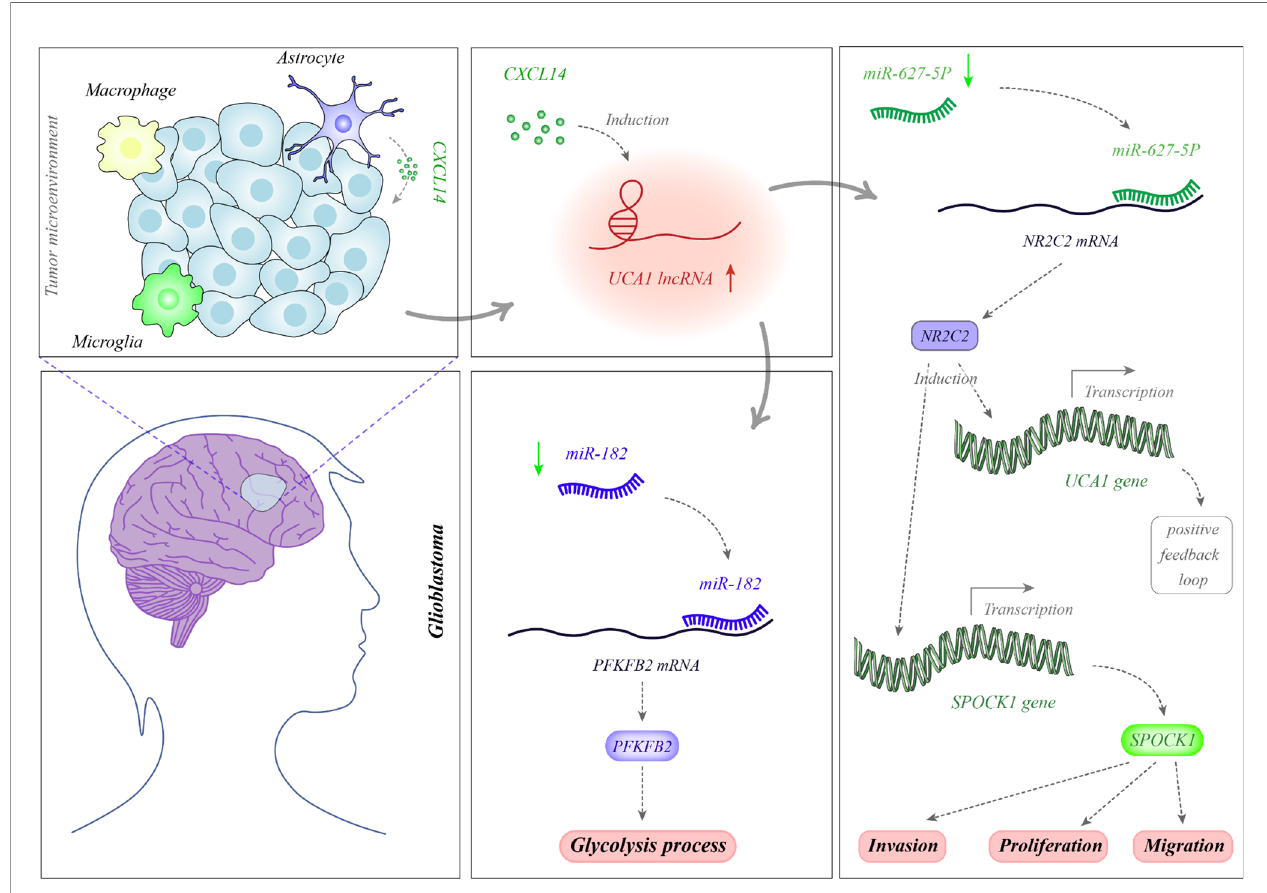
FIGURE 1 | Glioblastoma-associated stromal cells (GASCs) are special cells in the tumor microenvironment which are phenotypically and functionally similar to the cancer-associated fi broblasts. These cells produce CXCL14 which functions as a paracrine factor to enhance expression of UCA1. UCA1 serves as a sponge for miR-182. Since miR-182 suppresses expression of PFKFB2, UCA1 up-regulation results in up-regulation of PFKFB2 through sequestering miR-182. PFKFB2 protein increases glycolysis in the tumor cells (16). In addition, UCA1 decreases miR-627-5p levels. As miR-627-5p inhibits NR2C2 expression, down-regulation of miR-627- 5p by UCA1 enhances expression of NR2C2. NR2C2 binds with the promoter region of UCA1 and increase its expression through a positive feedback loop. Moreover, NR2C2 enhances expression of SPOCK1 increasing cell proliferation, migration and invasiveness of tumor cells